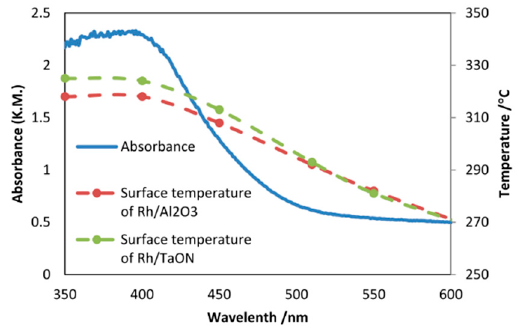
Figure 55. Overlay of the absorbance of Rh/TaON and the surface temperatures of Rh/TaON and Rh/Al 2 O 3 . Reproduced from [22] with permission from The Royal Society of Chemistry.